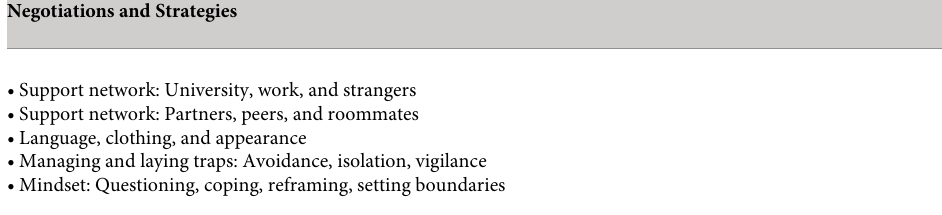
Table 2. Influences that create increased and/or decreased hidden labor for women. Negotiations and Strategies